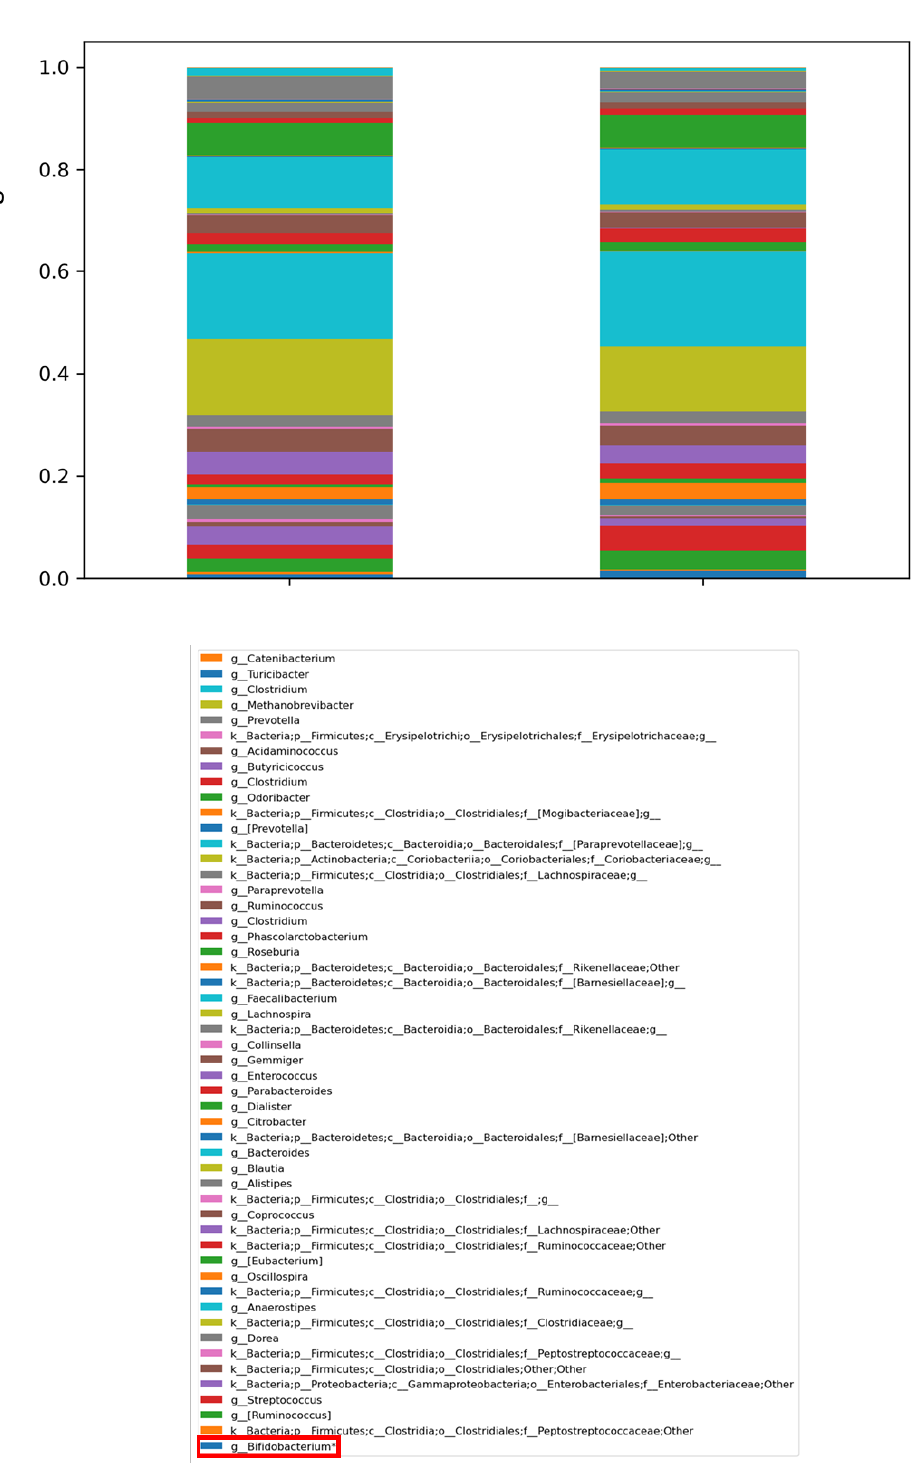
Figure 4. Histograms representing the relative abundancies of Amplicon Sequence Variant (ASV) distributions in the gut microbiota of patients at T 0 and T 1 , represented at taxonomic genus level (L6). The bacterial genera were compared by Kruskal-Wallis test. The box in red refers to the genus Bifidobacterium, relevant for the composition of the administered probiotic and filtered by statistical significance (* p value < 0.001).